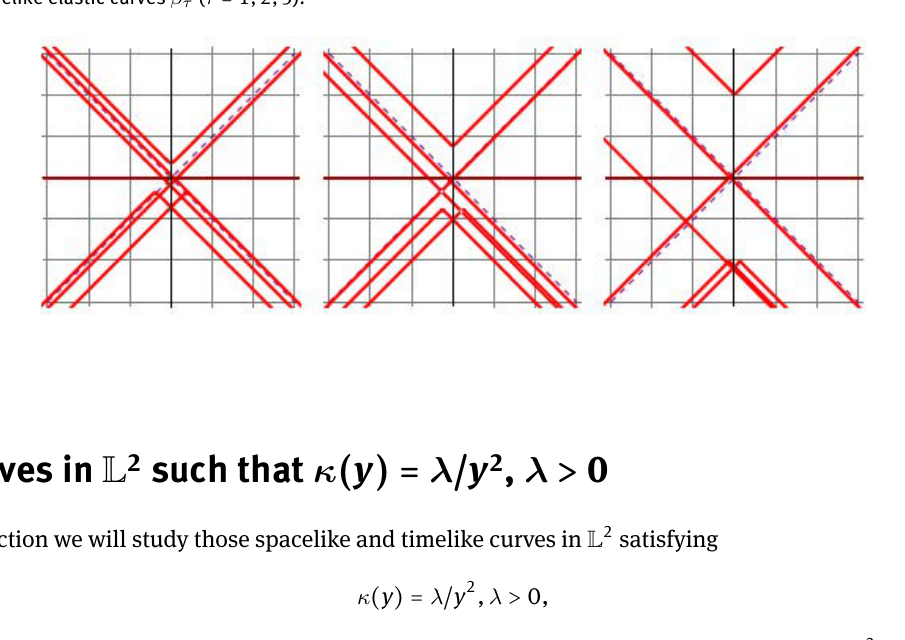
Fig. 10. Timelike elastic curves β τ ( τ = 1,2,3